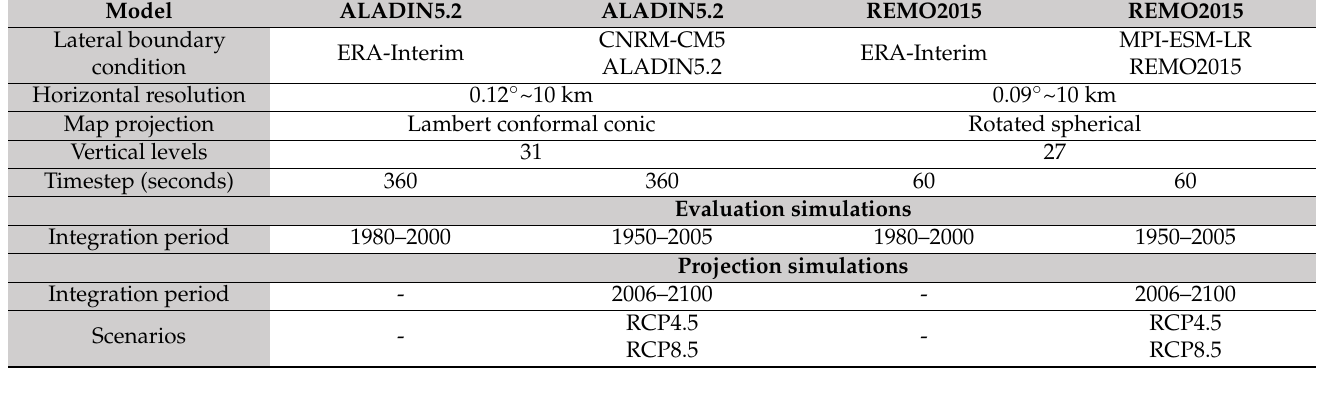
Table 2. Characteristics of the model experiments.